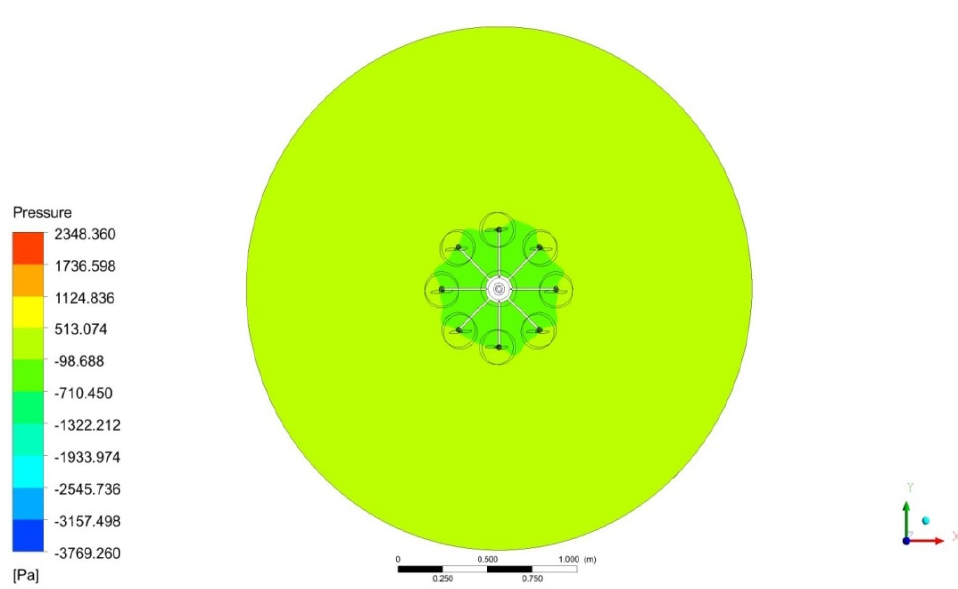
Figure 26. Pressure variations on the octocopter’s propellers.